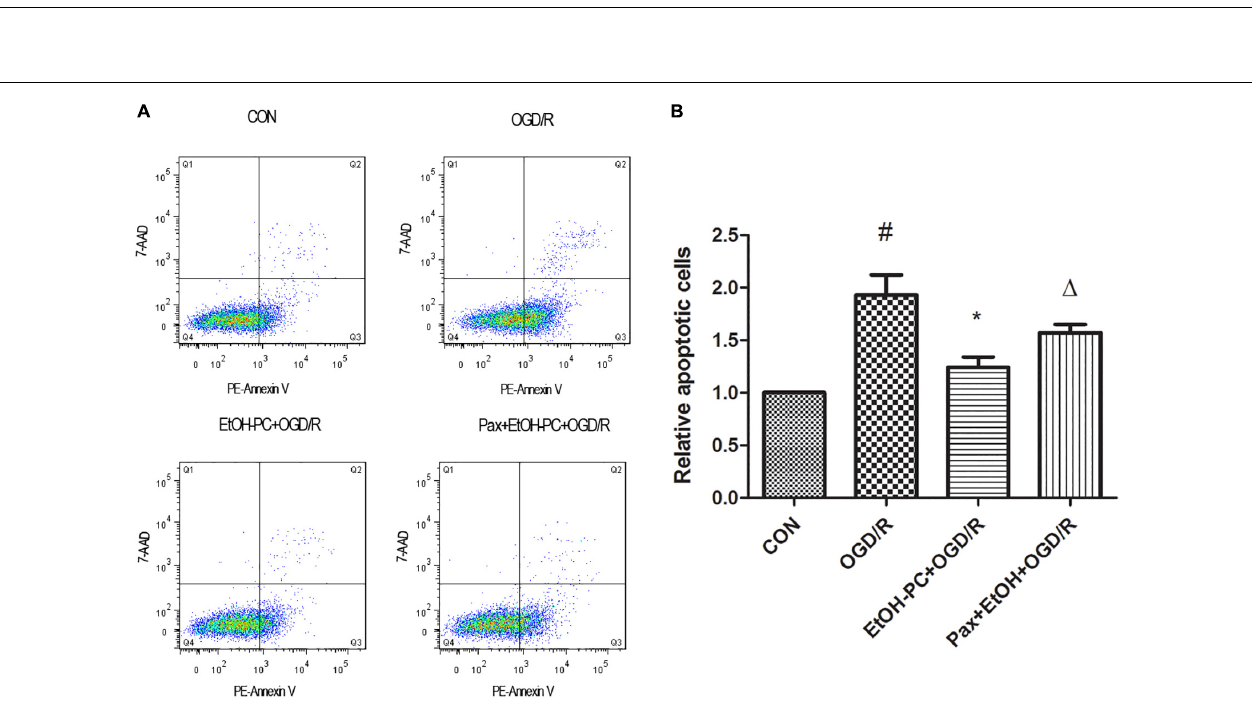
FIGURE 4 | Ethanol preconditioning protected against the OGD/R-induced neuronal apoptosis through activating BK Ca channel detected by flow cytometry. After the neurons were preincubated with paxilline (5 µ mol/L) for 10 min and preconditioned with ethanol (10 mmol/L) followed by OGD2h/R24h, the neurons were stained with Annexin V and 7-AAD and detected by flow cytometry (A) . Results are expressed as mean ± S.D. ( n = 5). # P < 0.01 vs. CON; * P < 0.05 vs. OGD/R; (cid:49) P < 0.05 vs. EtOH-PC + OGD/R (B) .